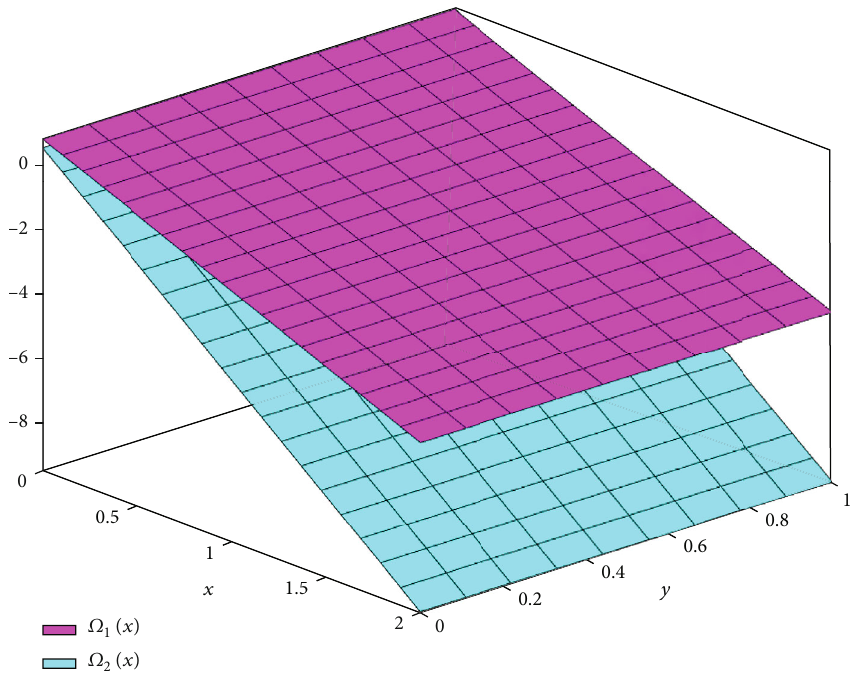
Figure 3: Behaviour of Theorem 9 via a three-dimensional plot satis fi es Example 10 approach. The equivalence between the system of